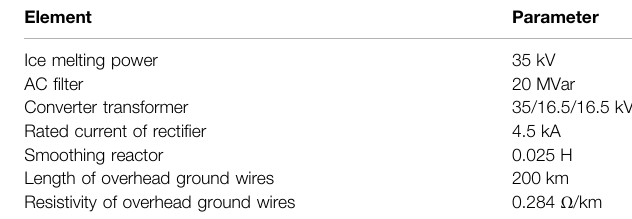
TABLE 1 | Component parameters of ice melting